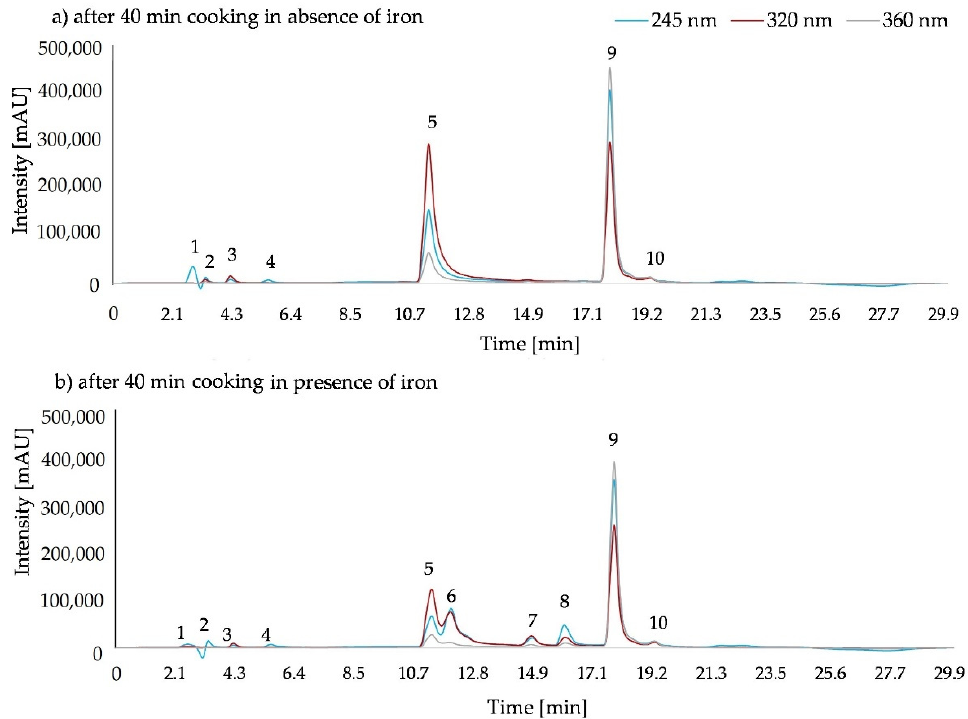
Figure 5. HPLC-DAD chromatograms of the 1:1:1 ratio of ascorbic acid, 5-caffeoylquinic acid, and quercetin-3-rutinoside ( a ) after 40 min cooking in the absence of iron, and ( b ) after 40 min cooking in the presence of iron. 1: ascorbic acid, 2: insert peak, 3: ascorbic acid derivate, 4: ascorbic acid derivate, 5: 5-caffeoylquinic acid, 6: caffeic acid; 7: 5-caffeoylquinic acid derivate, 8: quercetin-3-rutinoside derivate, 9: quercetin-3-rutinoside, 10: impurity of the quercetin-3-rutinoside standard.